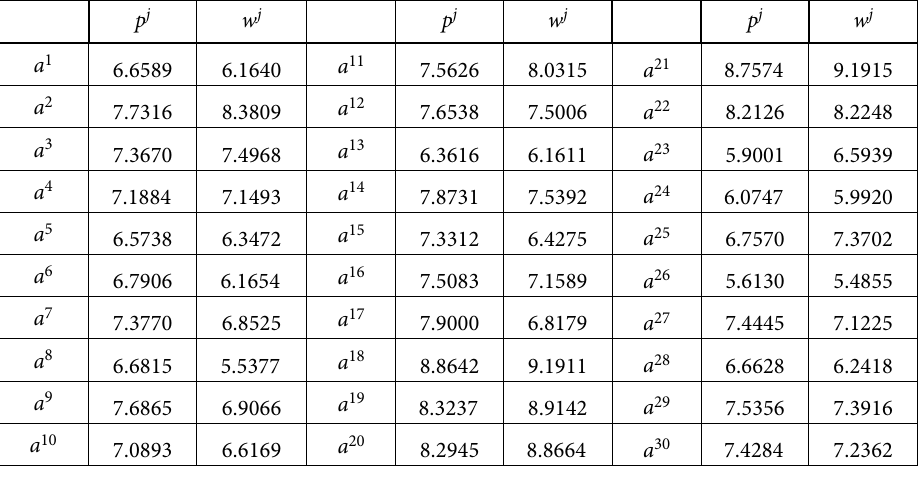
Table 1. Performance and importance of attributes (source: Wilkins, 2010) p j w j p j w j p j w